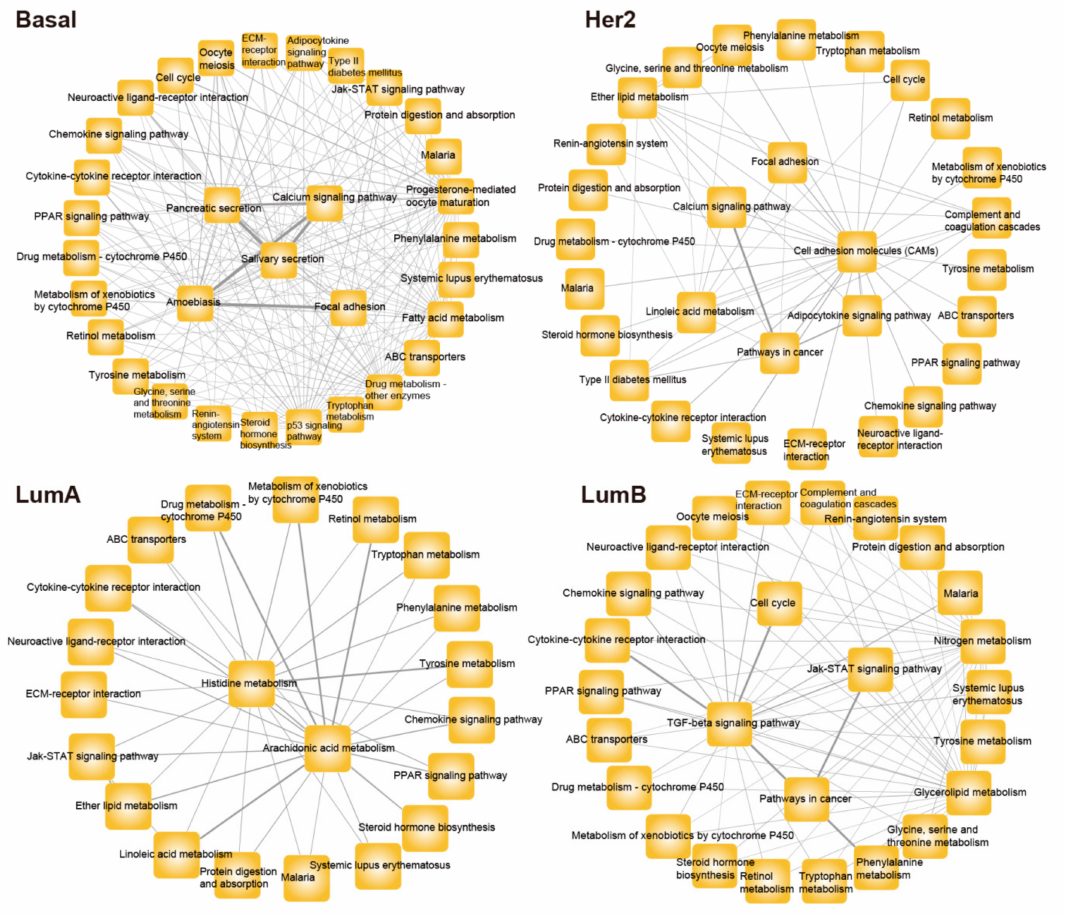
Figure 4. The specific crosstalk network of each breast cancer subtype. The yellow rectangle represents the pathways of the specific crosstalk network. The thickness of edges represents the intensity of crosstalk between pathways; the larger the crosstalk value, the thicker the